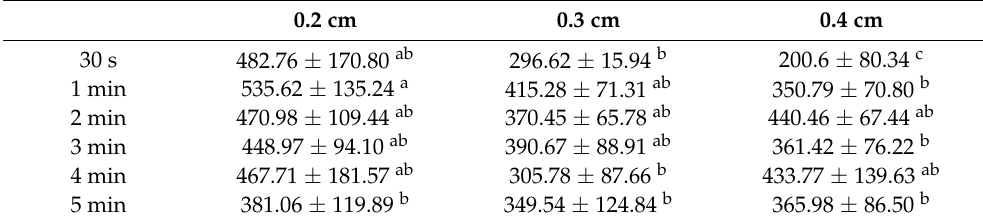
Table 3. Puffing ratio of fried pork rind with different raw pork skin thickness and frying